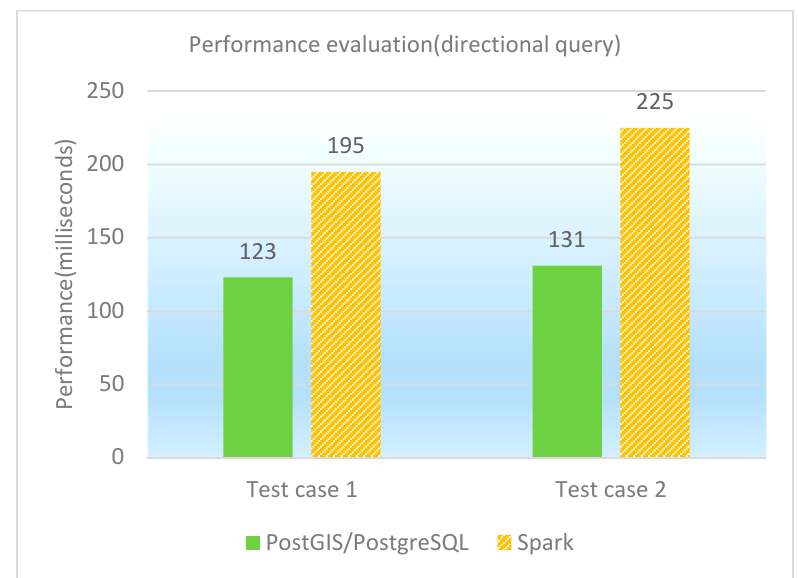
Figure 10. Performance comparison graph of directional queries (in milliseconds).